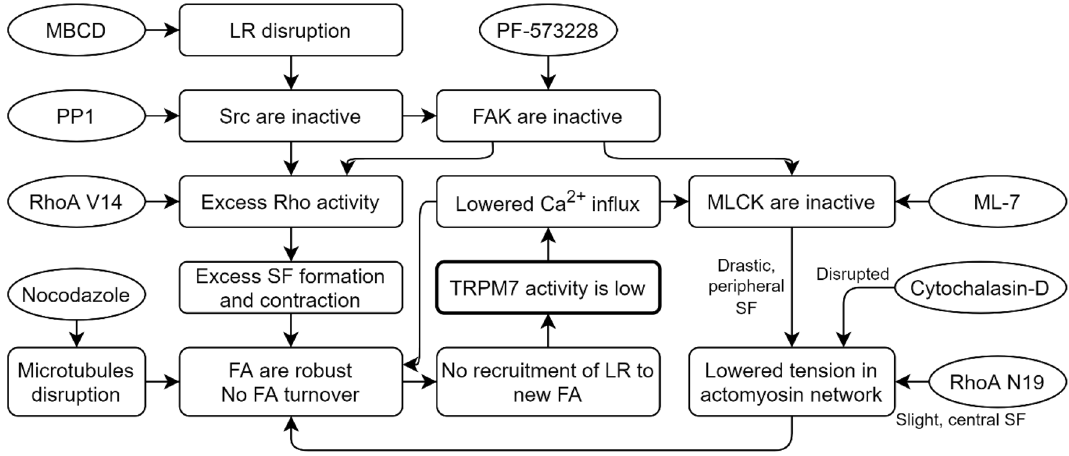
Figure 8. Flowchart showing the regulation of TRPM7 activity by the cell mechanosensitive apparatus components. Lipid raft disruption leads to Src inactivity 39 . Inactive Src does not phosphorylate FAK 17 and allows RhoA to be excessively active, which leads to excess SF formation and contraction, which causes FA robustness and hampers turnover 7 . The destruction of microtubules has the same effect on FA turnover 16 . FAK influences both Rho and MLCK 40 . Inactive MLCK drastically lowers SF tension on the periphery 36 , which may interfere with FA turnover. All interventions in this system lowered TRPM7 activity. Restricted Ca 2+ influx affected Ca 2+ - calmodulin-dependent MLCK 11 and FA turnover 38